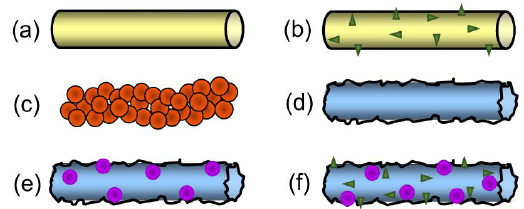
Figure 3. Sketch of the main electrospun fiber typologies produced ( a , b ) without and with ( c ) single- step or ( d − f ) multi-step post spinning heat treatment. (a) Polymer fibers; (b) polymer fibers with conductive carbonaceous additives; (c) oxide fibers; (d) porous carbon fibers; (e) composite carbon fibers; (f) composite carbon fibers with conductive carbonaceous additives.